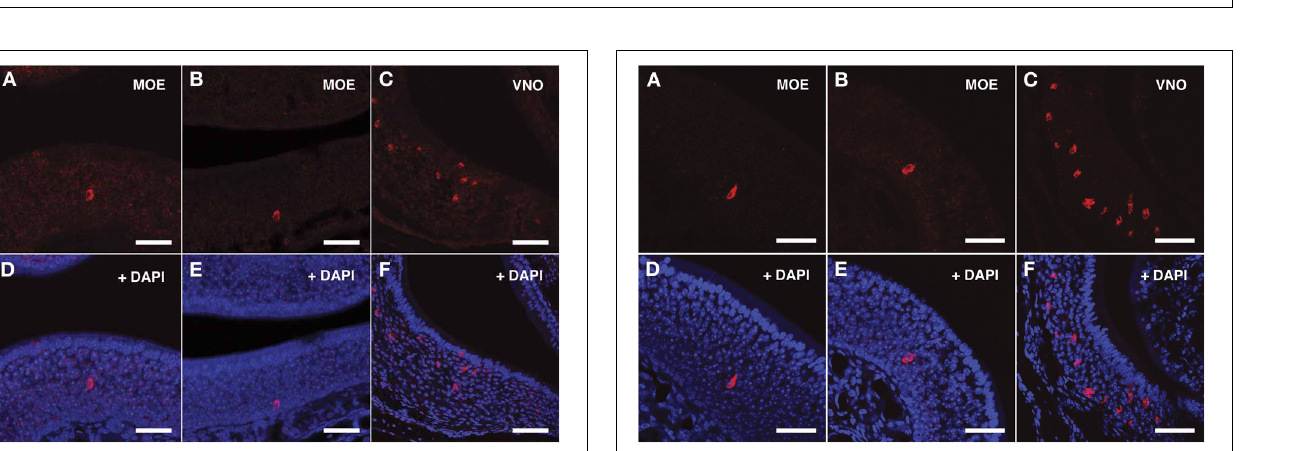
by nanoCAGE. DNA molecular weight Marker VI is used as DNA ladder (Roche Applied Science). (B) The TSS of Vmn2r69 identified by nanoCAGE was validated by RT-PCR with a forward primer designed in proximity of the TSSs and a reverse primer designed on the first exon. The sequence of the RT-PCR product is shown uploaded in the UCSC Genome Browser along with the nanoCAGE data.